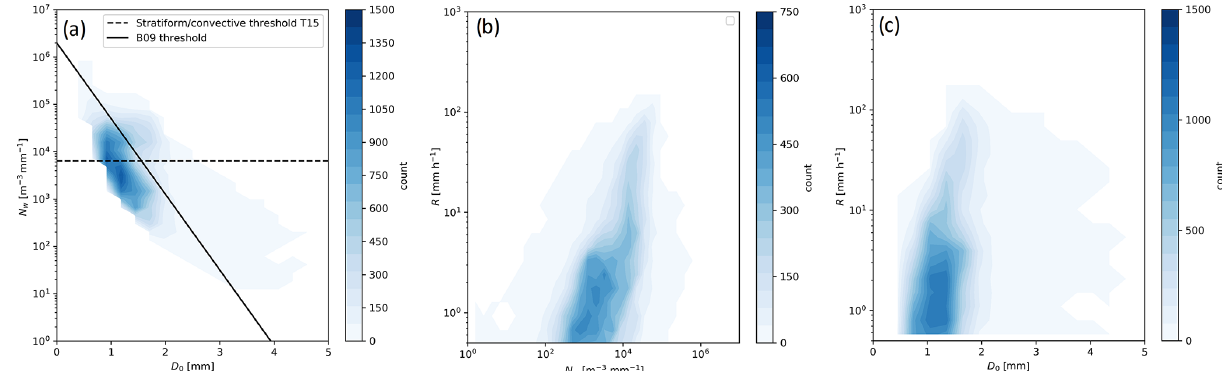
Figure 2. Frequency histogram of (a) N w and D 0 , (b) R and N w , and (c) R and D 0 from the VDIS for all of the DSDs containing more than 100 drops in each sample. The criteria used to classify stratiform and convective DSDs from Bringi et al. (2009) (BR09) and Thompson et al. (2015) (T15) are shown by the